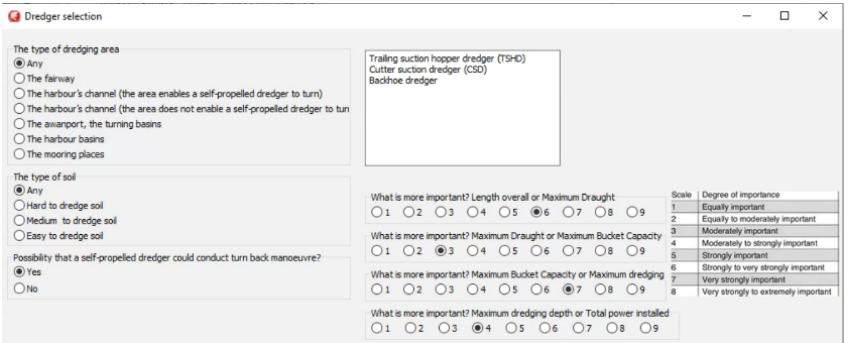
Figure 5. Dredger selection.